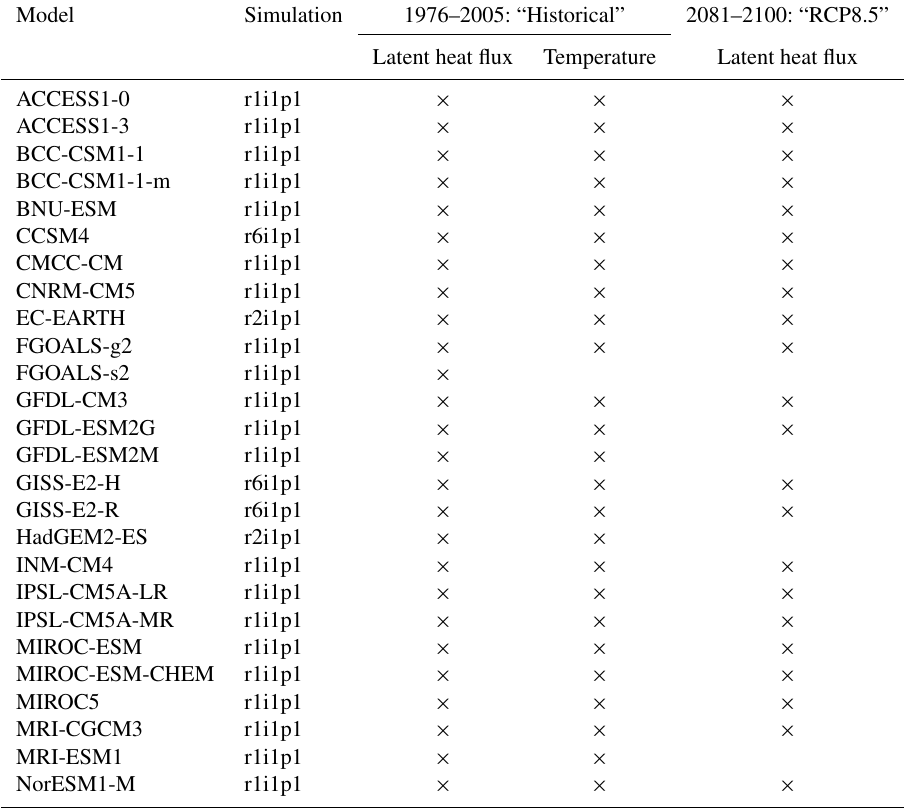
Table A2. Climate models or model configurations employed for the analysis. Note that there are slight variations depending on the time period/scenario and on the variable under